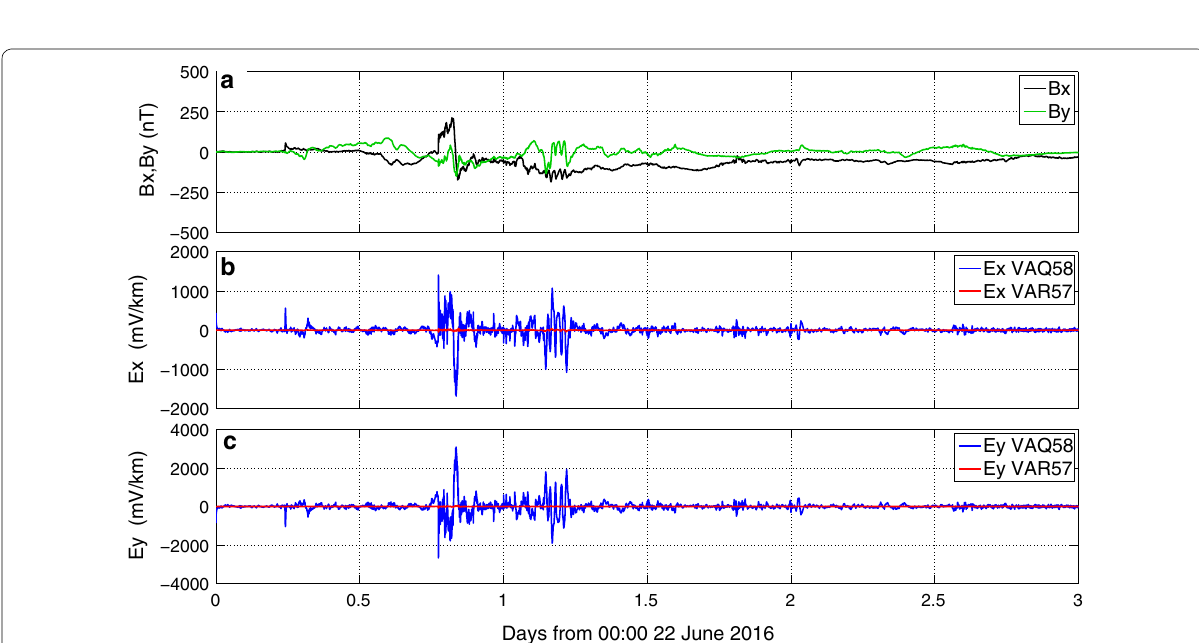
Fig. 5 Time series for geomagnetic fields at the Fredericksburg (FRD) Magnetic Observatory for the June 22, 2016, storm for 3 days beginning at 00:00 June 22, 2016, and corresponding estimated geoelectric fields. a 1 s resolution geomagnetic field B x ( t ) (black) and B y ( t ) (green) in nT defined relative to a constant baseline, b estimations of the geoelectric field E x for EarthScope impedance VAQ58 (blue) and VAR57 (red) in mV/km, c equiva- lent time series to ( b ) for the estimated E